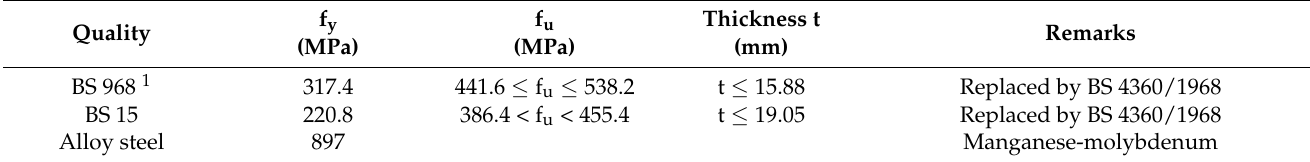
Table 3. Bailey bridge structural steel specifications.